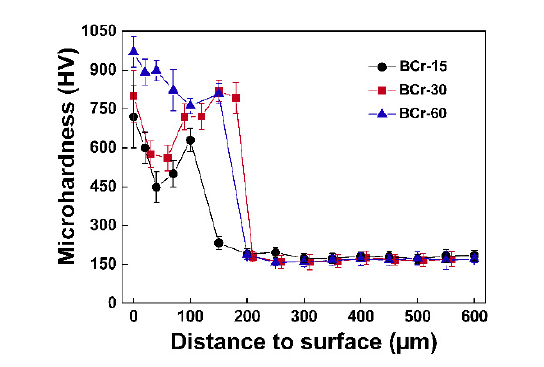
Figure 10. Microhardness plotted as a function of distance to the surface of the three